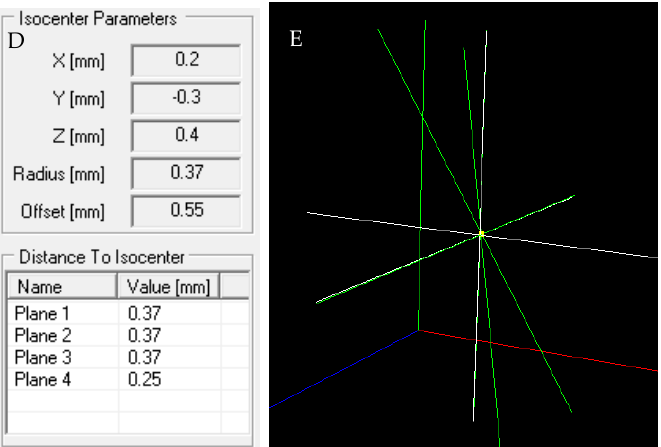
Figure 10. Isocenter determination: 3D option. PABIG nx in PH-5-DD1 GeVero Co. container was irradiated and scanned with the TrueBeam accelerator (iCBCT, mode: Pelvis, mean over 3 series; background (mean over 3 series) subtracted from the scans of the irradiated sample), and an isocenter was determined using the polyGeVero-CT software package (GeVero Co.). ( A ) is for transversal Z plane, ( B ) is for frontal Y plane, ( C ) is for sagittal X plane, ( D ) is a table with the results of the isocenter determination and ( E ) is for the 3D view of the isocenter determination; the yellow dot in the center corresponds to the isocenter.